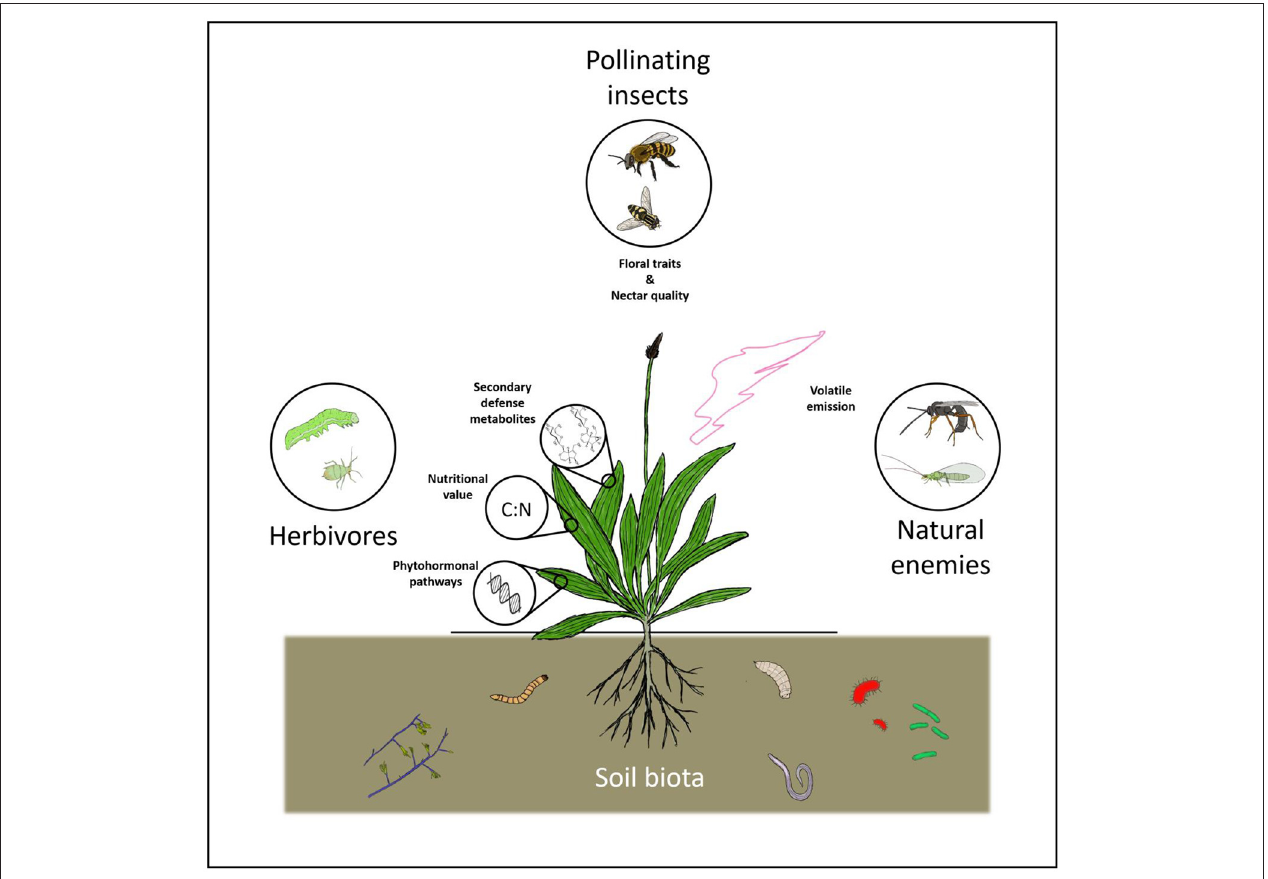
FIGURE 1 | A schematic overview of mechanisms through which soil organisms can affect plant phenotype and associated aboveground insects. Soil organisms can affect a variety of host plant traits, including nutritional quality and palatability, size, morphology and floral traits, as well as the activation of defense pathways and the emission of plant volatile organic compounds. Through these mechanisms they can influence insect herbivores, pollinators and natural